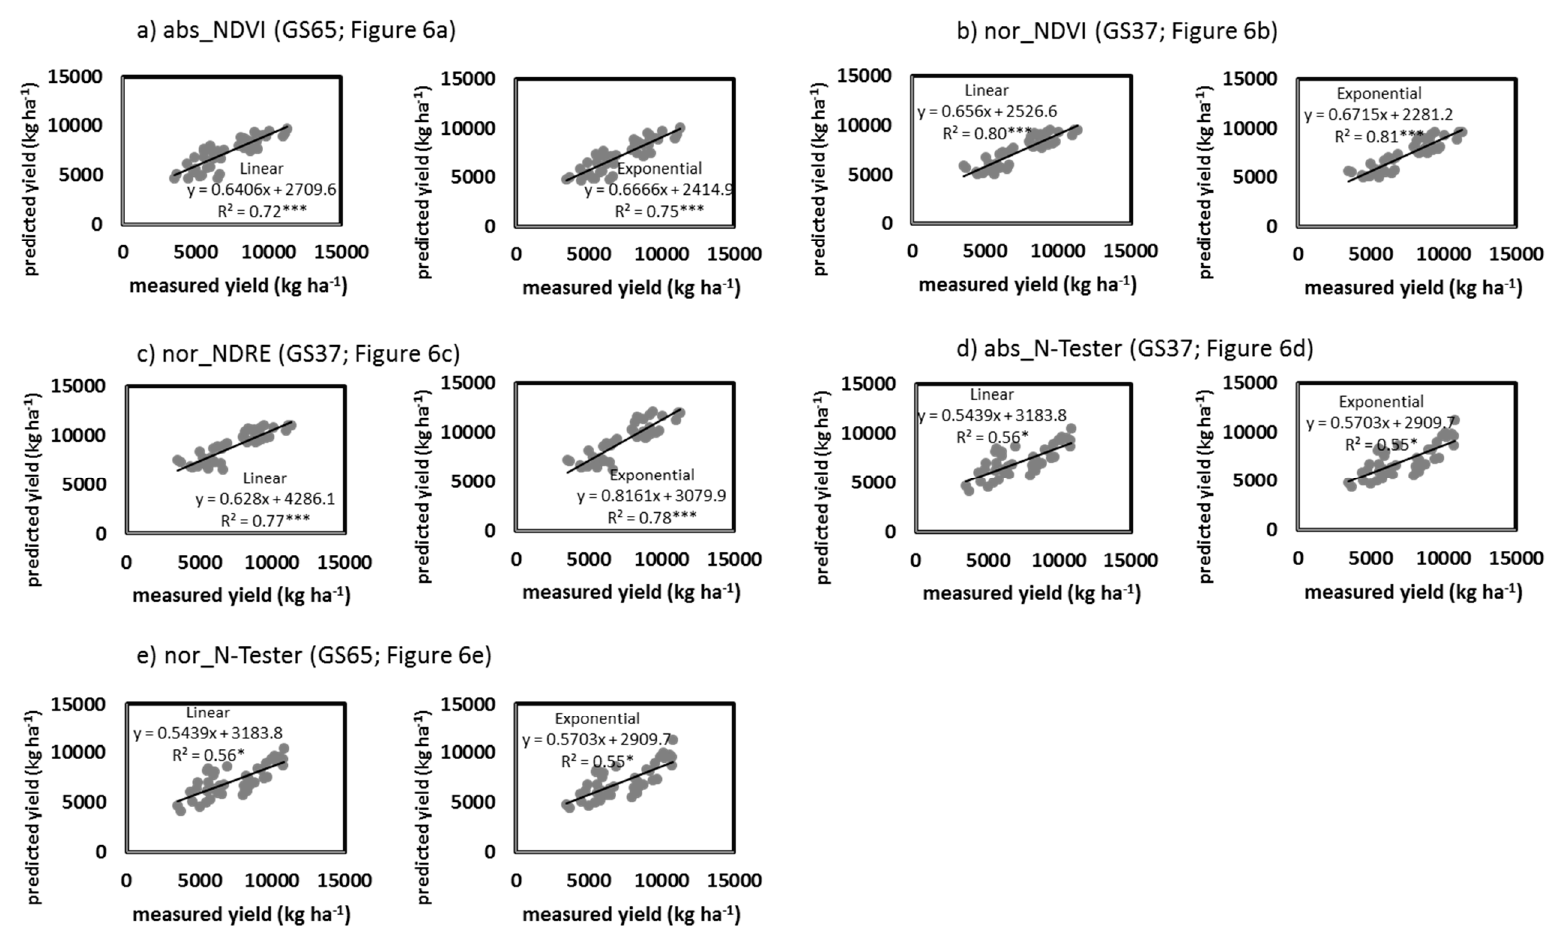
Figure 10. Relationships between the predicted yield values (from abs_NDVI at GS65 ( a ), nor_NDVI at GS37 ( b ), nor_NDRE at GS37 ( c ) abs_N-Tester at GS37 ( d ) and nor_N-Tester ( e )) and the measured yield values from 25% of the samples. *,*** Significant at 0.05 and 0.001 probability levels, respectively. abs, absolute values; nor, normalized values; NDVI, Normalized Di ff erence Vegetation Index; NDRE, Normalized Di ff erence Red Edge Index.